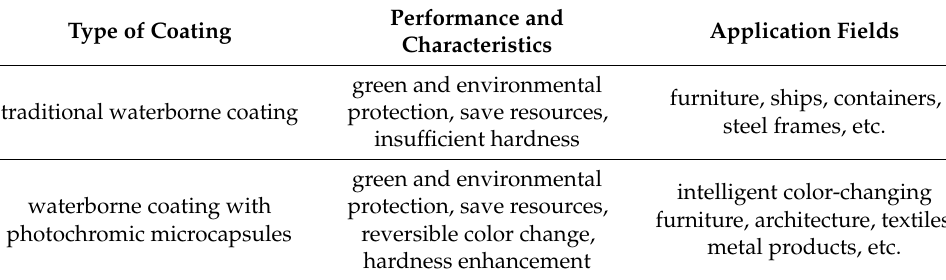
Table 1. Comparison of two